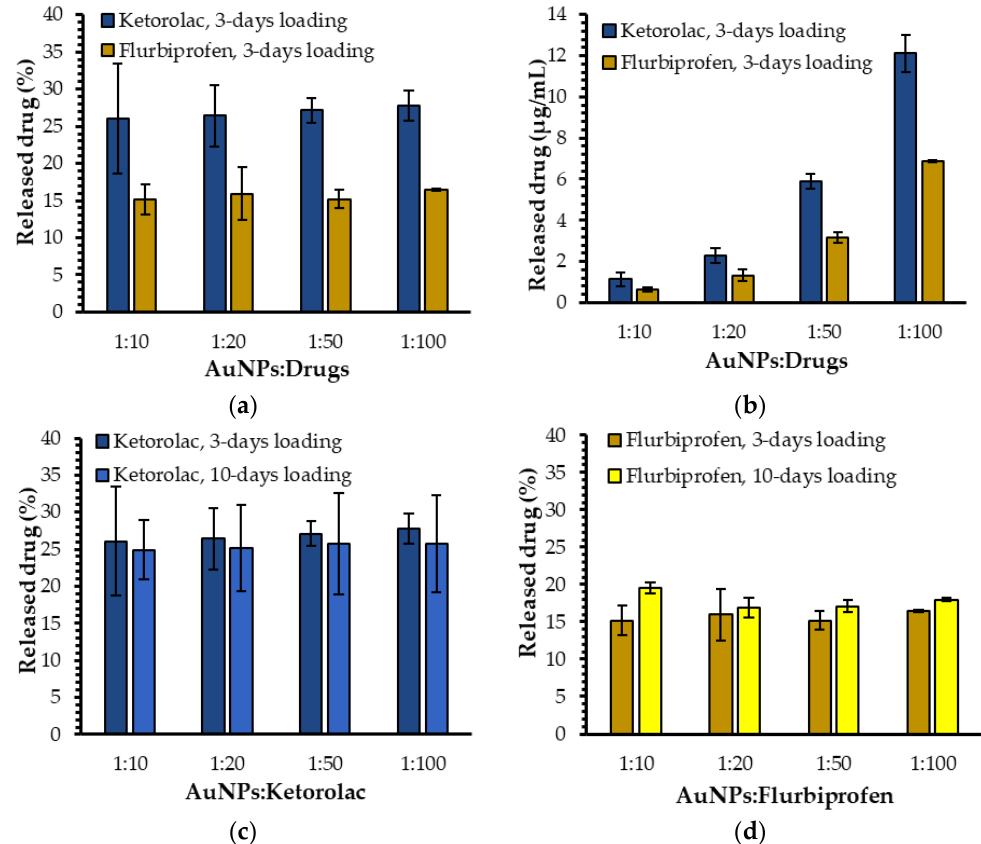
Figure 2. ( a ) Drug release percentages of ketorolac and flurbiprofen for the 3-day loading time; ( b ) drug release concentrations for ketorolac and flurbiprofen for the 3-day loading time; ( c ) comparison of ketorolac release percentages for the 3-day and 10-day loading times; ( d ) comparison of flurbiprofen release percentages for the 3-day and 10-day loading